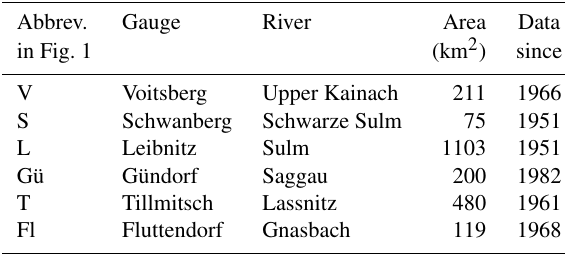
Table 1. Stream gauges used for evaluation (Fig.